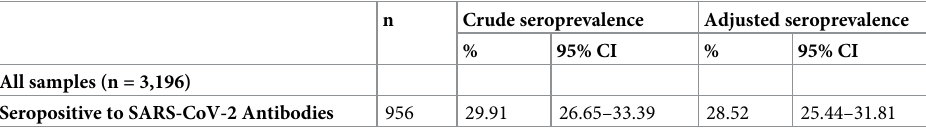
Table 1. Seroprevalence of antibody against SARS-CoV-2 in Tanjung Priok. n Crude seroprevalence Adjusted seroprevalence % 95% CI % 95% CI All samples (n = 3,196) Seropositive to SARS-CoV-2